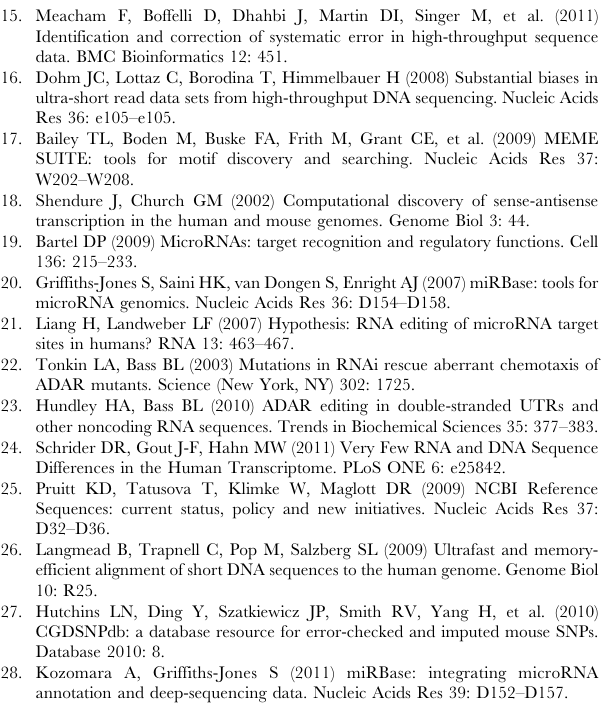
Figure S2 Non-canonical RNA editing candidates with a significant strand bias fail to validate through Sanger sequencing. Results are shown as in Fig S1. Figure S3 Distribution of average editing ratios for canonical and non-canonical editing sites. A) In bone samples, and B) in liver samples. The x-axis is sorted by editing ratio. Figure S4 Canonical sites with a strand bias, and a non- canonical site without strand bias fail to validate. A) Sanger sequencing of 3 canonical sites with a significant strand bias. B) Sanger sequencing of 1 non-canonical site without a significant strand bias. Figure S5 Examples of DNA polymorphisms within the Hjurp gene.